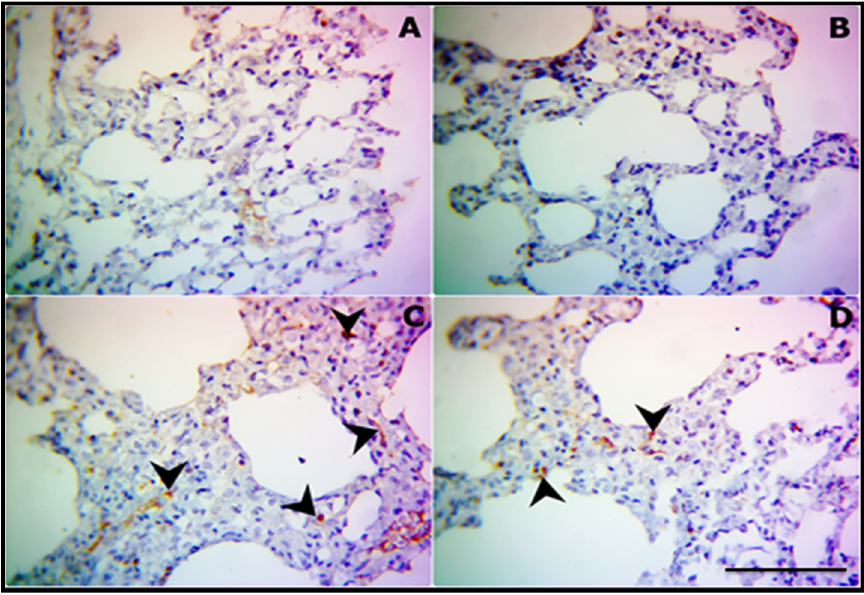
Figure 3. CUR attenuates apoptosis in lung of CP-induced rats. Representative photomicrograph of caspase-3 expression in lung sections of control ( A ), CUR-supplemented ( B ), CP-intoxicated ( C ), and CP-intoxicated rats treated with CUR ( D ). (400 × , scale bar = 50 µ